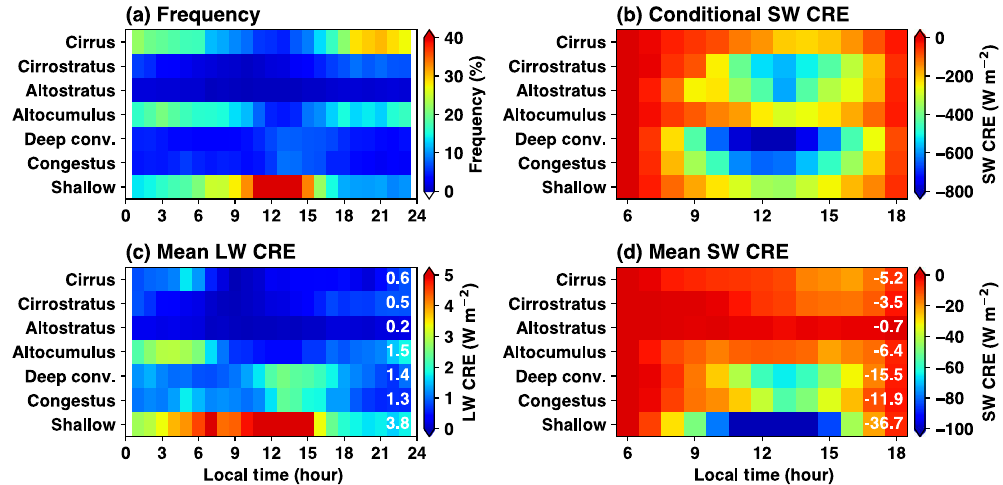
Figure 10. Mean cloud frequency and CRE for all GoAmazon2014/5 data. (a) Cloud frequency of occurrence as the lowest cloud in the column as a function of the diurnal cycle ( x axis), (b) conditional SW CRE, (c) mean LW CRE (frequency of occurrence times for the conditional LW CRE) and (d) mean SW CRE (frequency of occurrence times for the conditional SW CRE). Note that panels (a, c) are for all hours and (b, d) are for daytime hours only. The white boxes are hours with insufficient data. The white numbers in panels (c, d) show the mean CRE values (in Wm − 2 ) averaged across the diurnal cycle (including nighttime). Table 3. Mean downwelling SW radiative flux (SWdn), estimated clear-sky SW radiative flux (CSWdn), aggregate SW cloud radiative effect (SW CRE; SWdn – CSWdn), downwelling LW radiative flux (LWdn), estimated clear-sky LW radiative flux (CLWdn) and aggregate LW cloud radiative effect (LW CRE; LWdn – CLWdn). All units are in Wm − 2 and are averaged across the diurnal cycle. The Darwin, Manus and Nauru results are taken from Burleyson et al. (2015) (Table